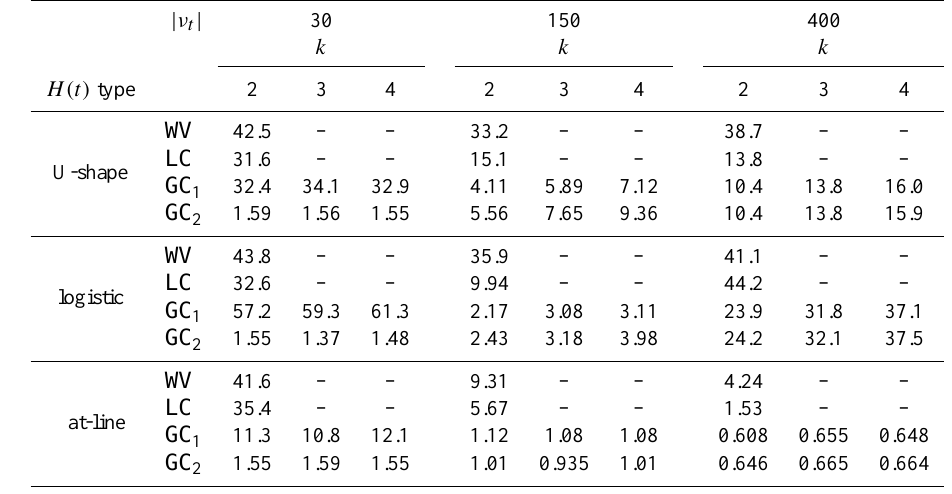
Table 2. MSE averages for different neighborhood sizes ( ν t ) and the exponent in absolute moments ( k ) depending on the three test functions through one thousand mBm series for each case are shown.